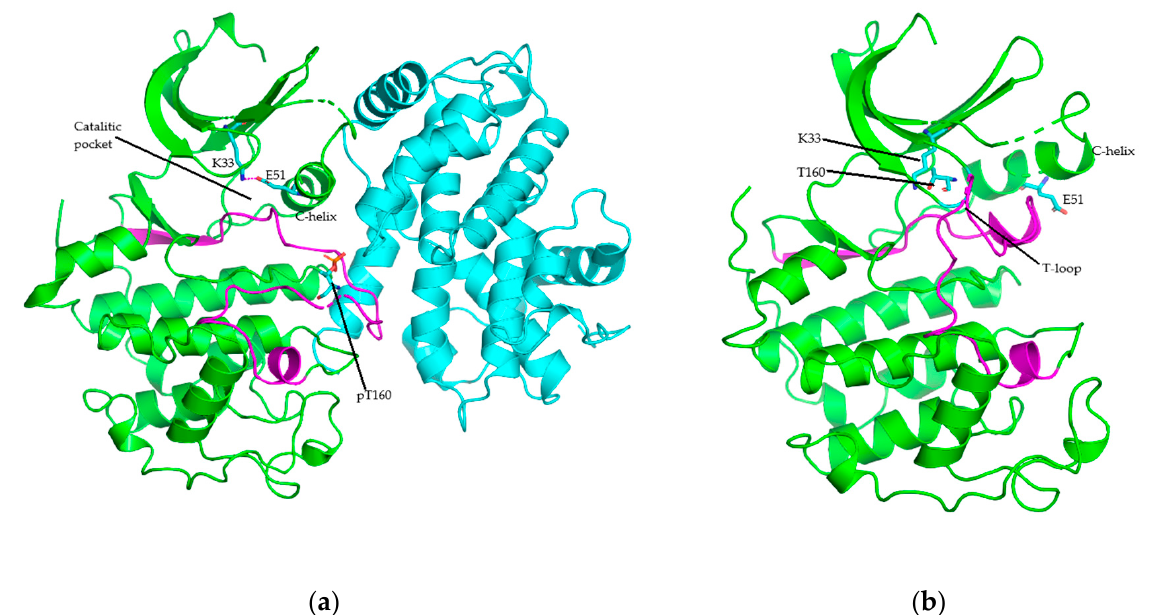
Figure 1. Structure of ( a ) CDK2 (green) bound with cyclin A (cyan) (PDB ID: 4EOQ), and ( b ) monomeric CDK2 (PDB ID: 1HCL). Activation segment in magenta.